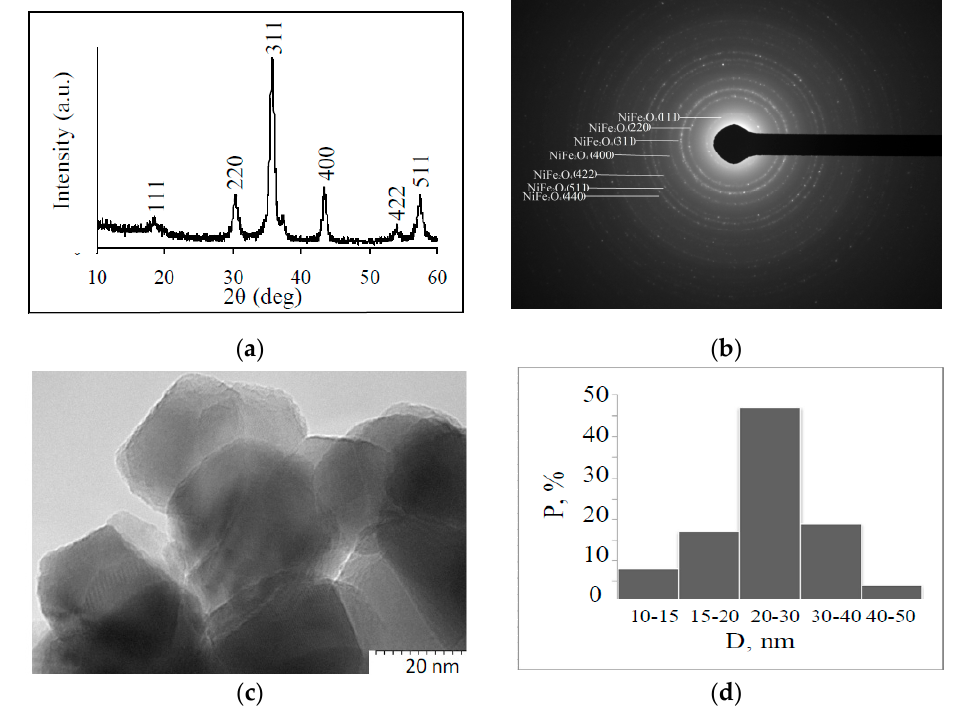
Figure 1. ( a ) XRD pattern, ( b ) electron diffraction pattern, ( c ) TEM image, ( d ) size distribution histogram of nickel ferrite particles synthesized by co-precipitation in the solution containing 0.2Ni(NO 3 ) 2 + 0.4Fe(NO 3 ) 3 + 0.01 cetrimonium bromide (CTAB) + 2 × 10 − 3 mol/L tartaric acid + 1 mol/L NaOH up to pH = 10 at 25 °C for 5 min.